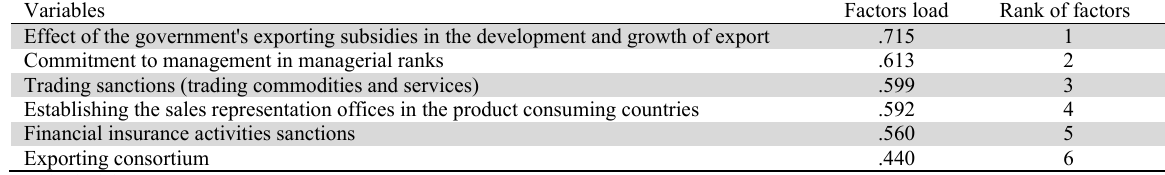
The summary of the opportunities/challenges factors influencing on creativity Variables Effect of the government's exporting subsidies in the development and growth of export